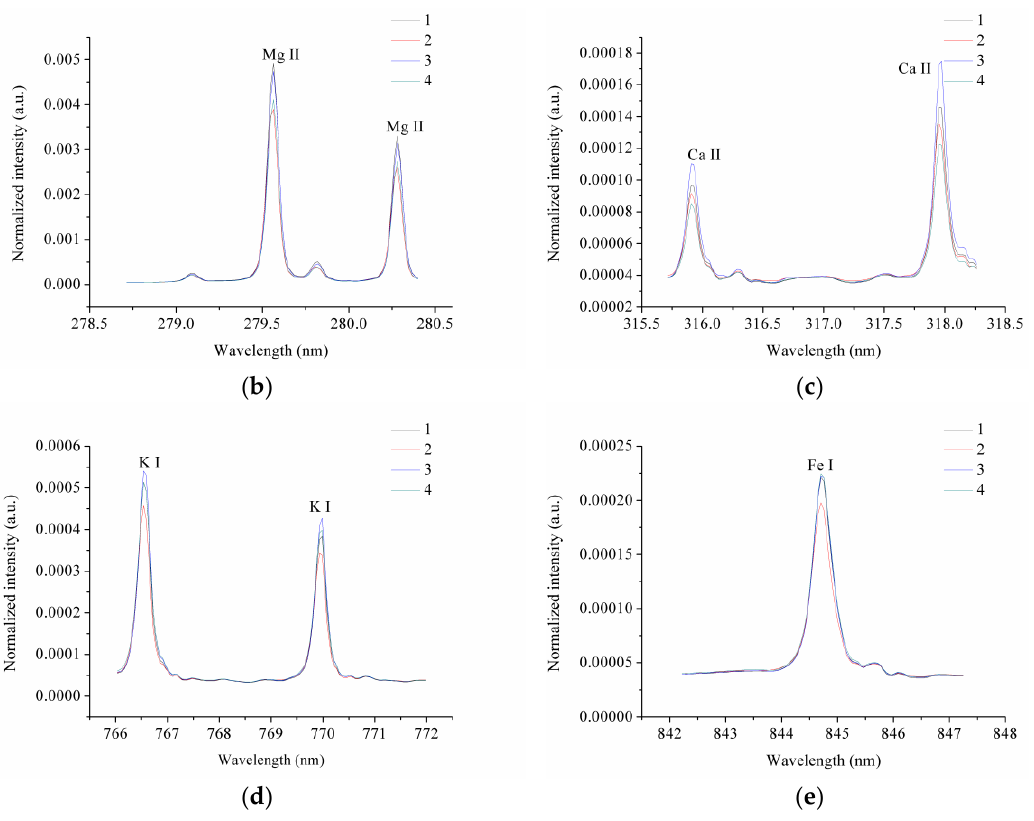
Figure 2. ( a ) The average laser-induced breakdown spectroscopy (LIBS) spectra of four different coffee varieties, and some typical peaks of ( b ) Mg II, ( c ) Ca II, ( d ) K I, and ( e ) Fe I. (a.u.: arbitrary unit).